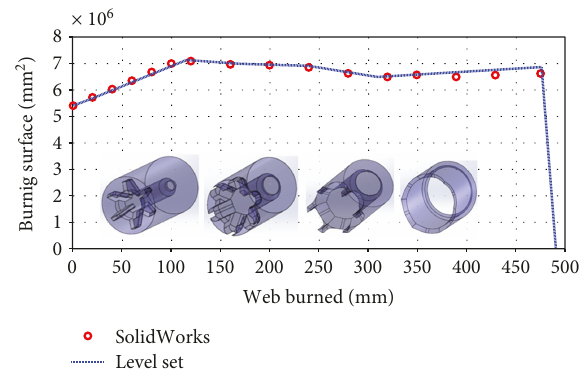
Figure 5: Burning surface vs. the web-burned validated by CAD software